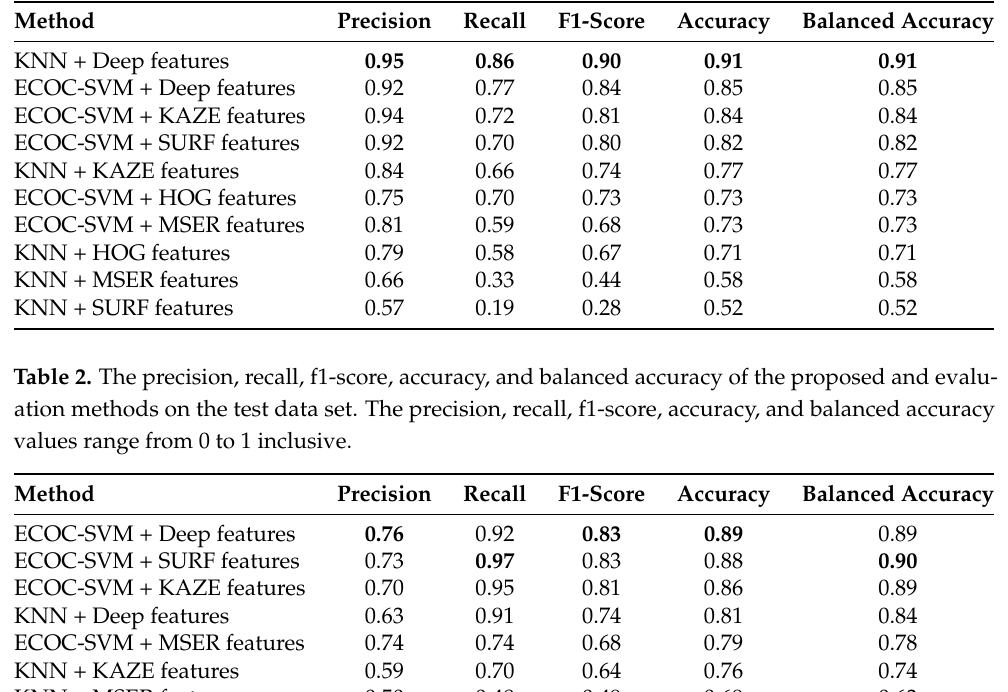
Table 1. The precision, recall, f1-score, accuracy, and balanced accuracy of the proposed and evalua- tion methods on the training data set. The precision, recall, f1-score, accuracy, and balanced accuracy values range from 0 to 1 inclusive.